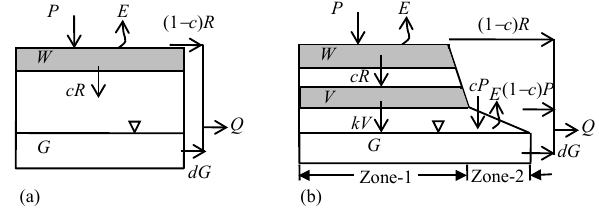
Figure 4. Schematic representations of the ABCD model (a) and ABCD-GE model (b) . W and V are the effective soil water storage and the effective storage in the transition vadose zone, respectively. G is the effective groundwater